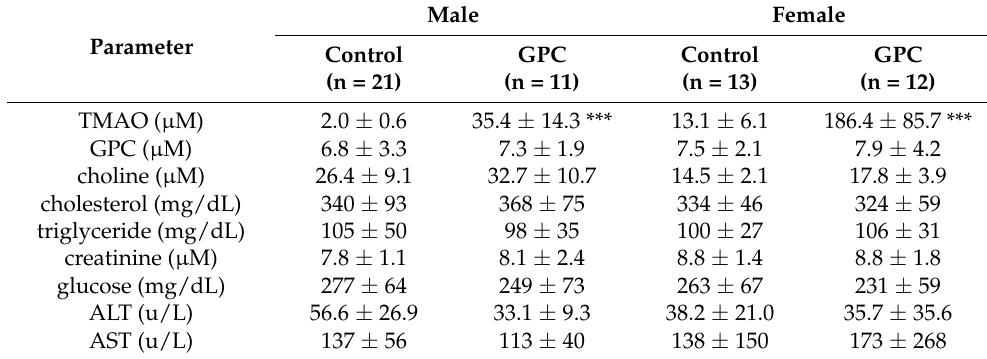
Table 1. Plasma metabolites and ALT, AST in C57BL/6J Apoe − / − mice after being fed GPC supple- mented chow diet vs. control diet for 16 weeks.